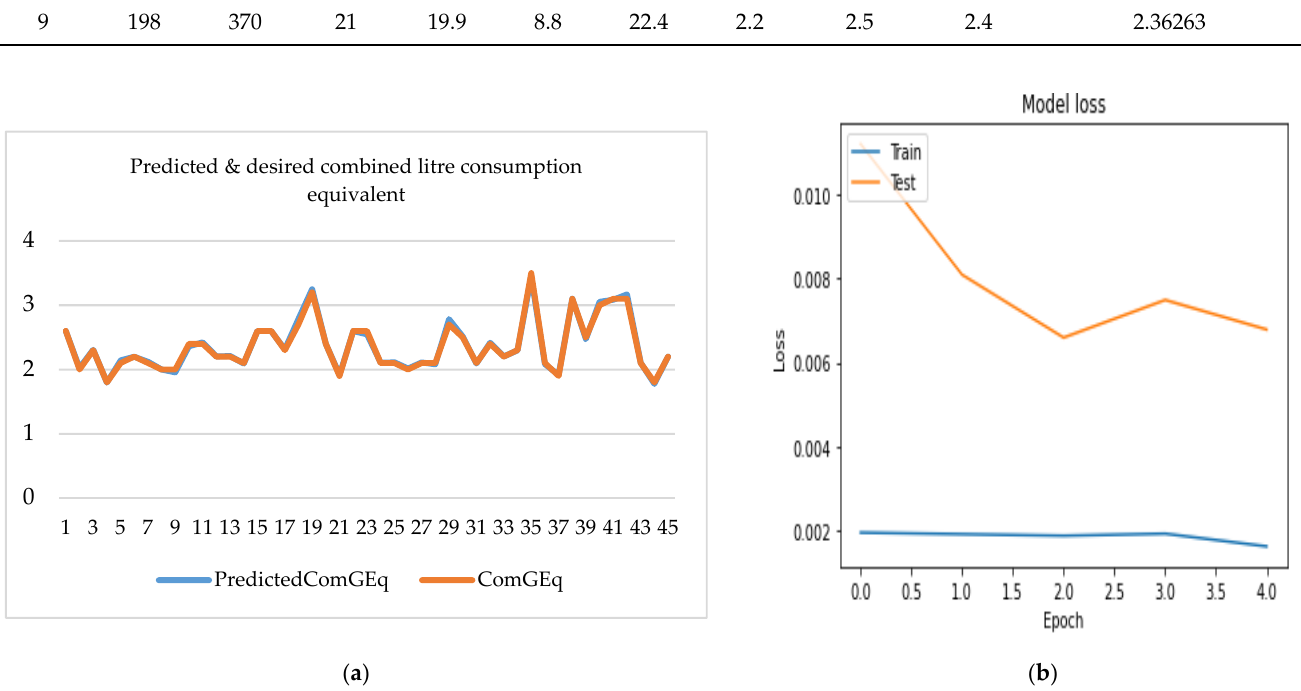
Figure 12. Combined gasoline litre consumption equivalent analysis. ( a ) Behaviour of the combined litre consumption equivalent; ( b ) Model loss with increase in epoch.